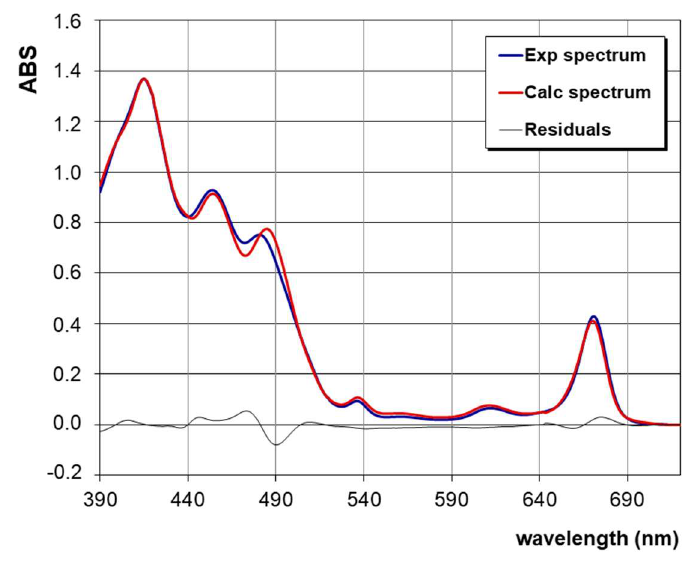
Figure 1. Example of near UV-vis absorption spectrum of an extra-virgin olive oil (EVOO) sample (namely T1), recorded in the range of 390–720 nm. Experimental (blue) and calculated (red) curves are reported with the residuals (black) curve.